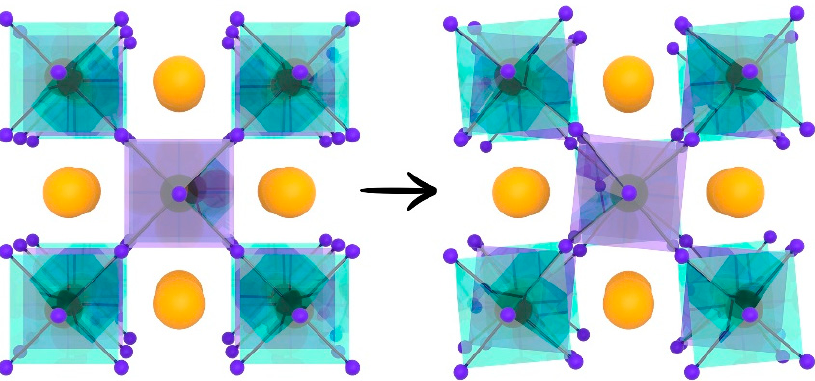
Figure 3. Structural phase transition of Sr 2 MMoO 6 from cubic to tetragonal lattice associated with the rotation angle of the MO 6 and MoO 6 octahedra. Reproduced with permission [32]. Copyright 2003, Elsevier.